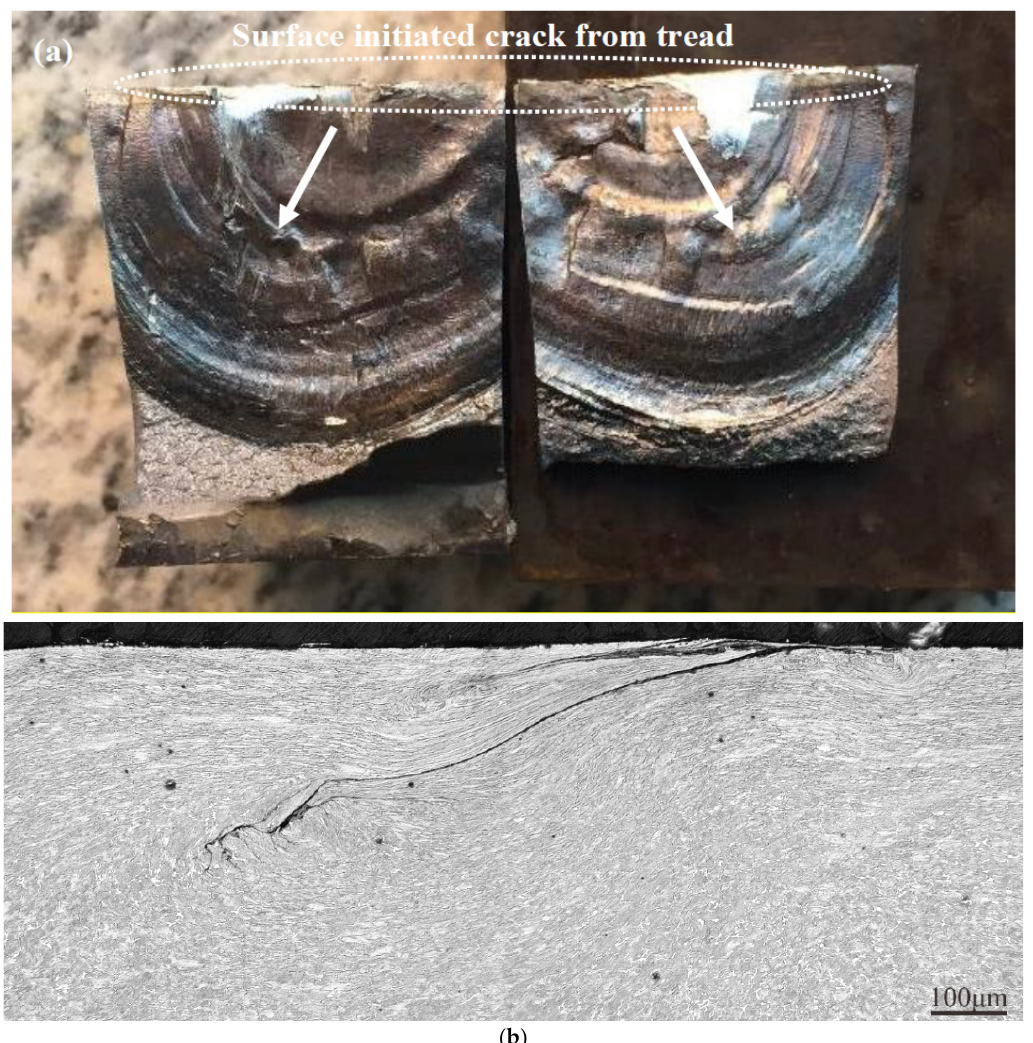
Figure 2. Typical rolling contact fatigue in wheels: ( a ) opening crack surface; ( b ) crack path and plastic deformation.